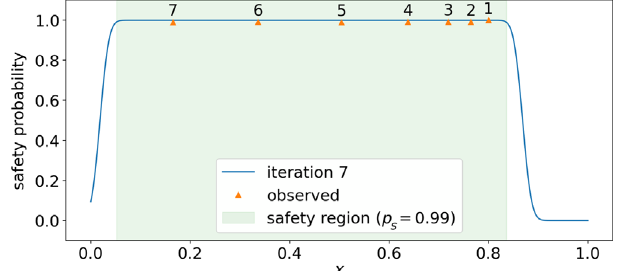
FIG. 1. Snapshot of the safety probability along the viable range at the end of 1D safety exploration. The safety probability curve is calculated with the seven given observations. The order of sampling is indicated by the number on top of each obser- vation. Orange triangles denote the observations, the blue curve shows the calculated safety probability, and the safety region with ¼ 0 . 99 is highlighted in green. safety probability threshold p s